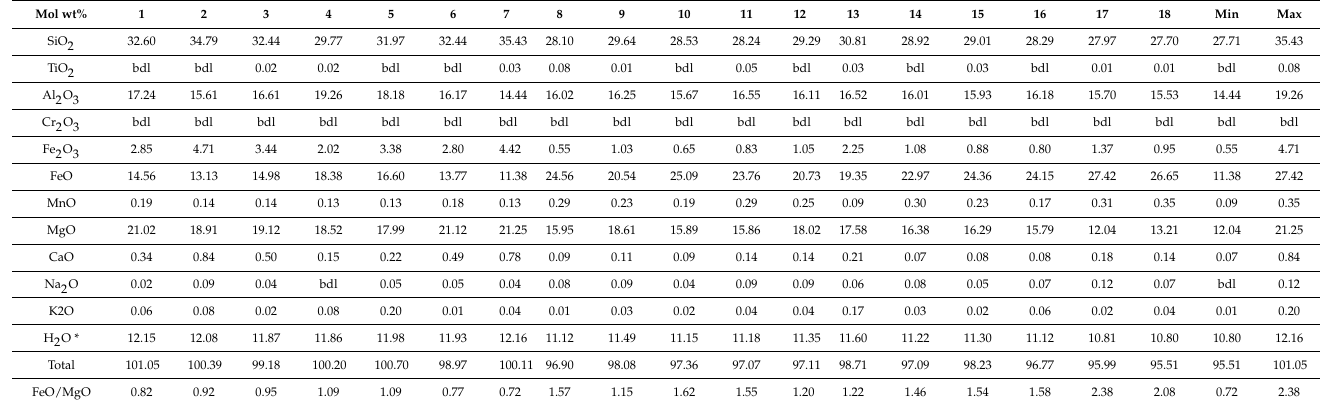
Table 3. Mineral chemistry of chlorite in the polymetallic uranium deposit of